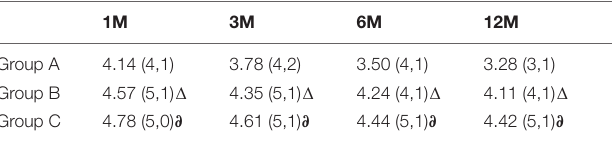
Data expressed as the mean (median ± quartile range); group B compared to group A, (cid:49) P < 0.05; group C compared to group A, ∂ P < 0.05; group C compared to group B, #P < 0.05.